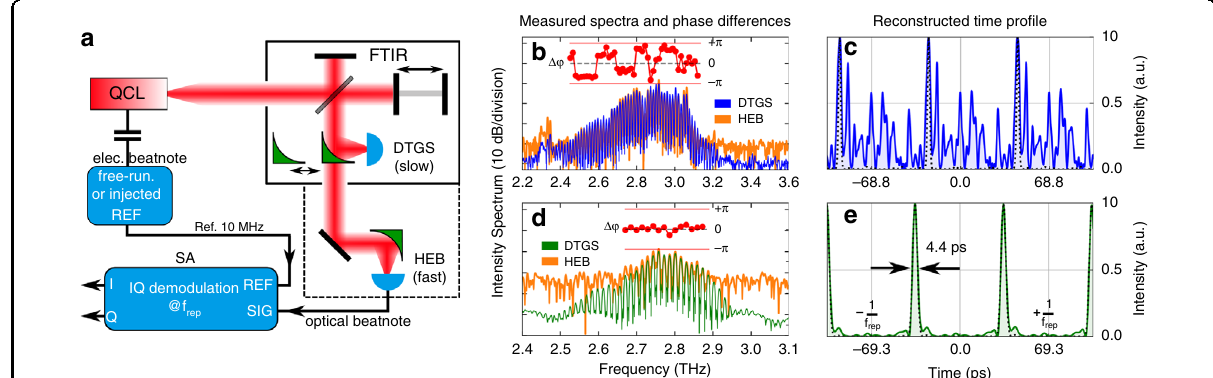
Fig. 5 SWIFT Spectroscopy on a planarized ridge device with different RF injection powers. a Schematic of the SWIFTS setup, featuring an FTIR and a hot electron bolometer (HEB) as a fast detector. b , c Measurements of a weakly-injected free-running ridge device show scattered phase differences, and the reconstructed time pro fi le has a quasi-continuous periodic output intensity. d , e Strong RF injection ( + 32 dBm at the source) close to the repetition rate frequency on a ridge device close to lasing threshold results in active mode locking, producing pulses as short as 4.4 ps (close to the Fourier limit, dotted line). Here, the signal-to-noise ratio of the HEB measurement is reduced due to RF pickup problems with stronger RF